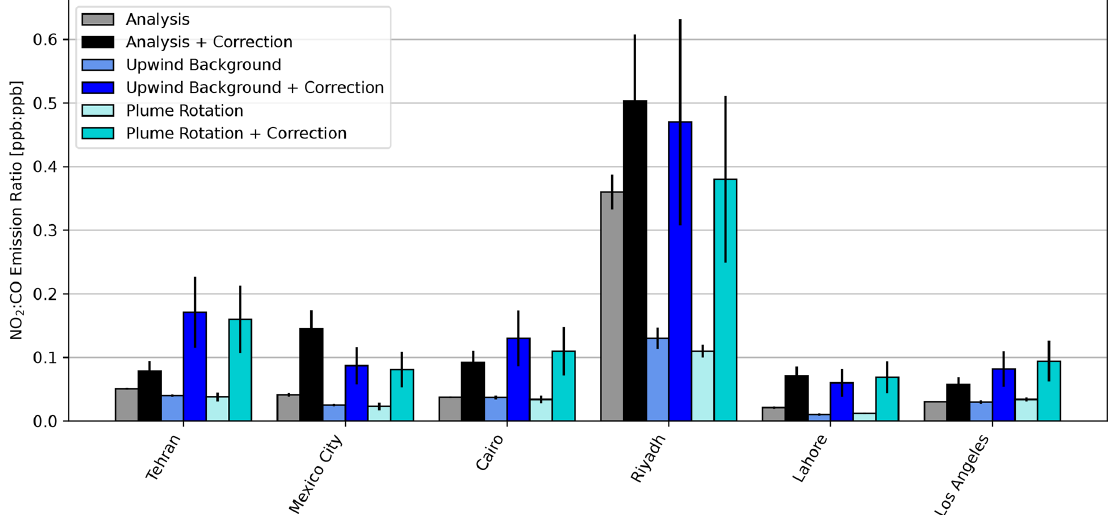
Figure 9. Comparison of our observed NO 2 : CO ratios (analysis and analysis + correction) to those calculated by Lama et al. (2020). Lama et al. (2020) use two different methods to compute enhancements: their “upwind background” method and their “plume rotation” method. Both are shown here, with and without their respective lifetime corrections.